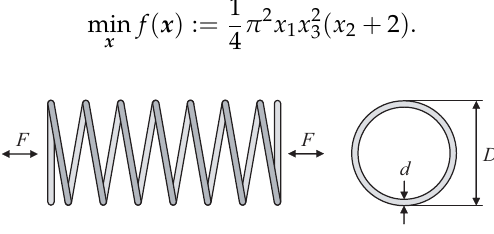
Figure 5. Configuration of a helical compression spring. Table 4. Discrete allowable values of the spring wire diameter d